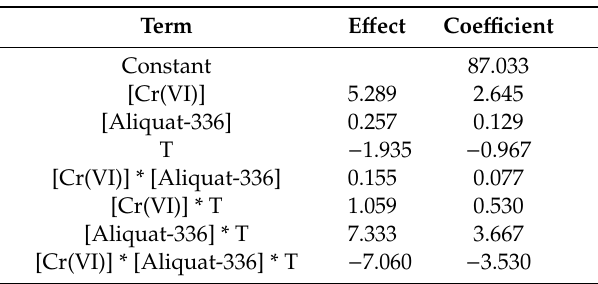
Table 6. Factor e ff ects and their coe ffi